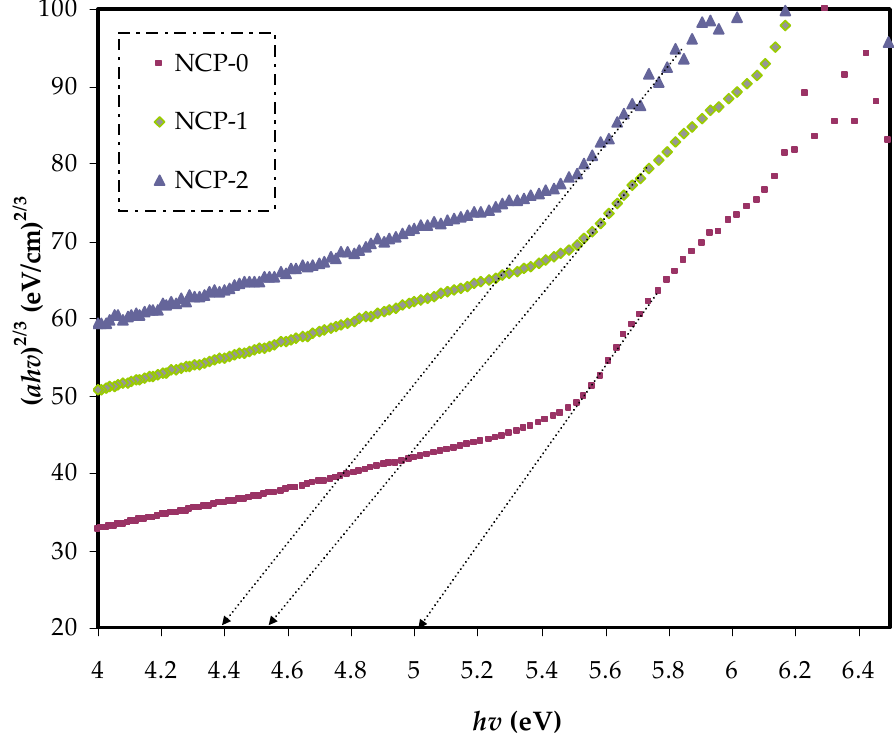
Figure 9. ( α h υ ) 2/3 v photon energy for NCP-0 and composite samples.